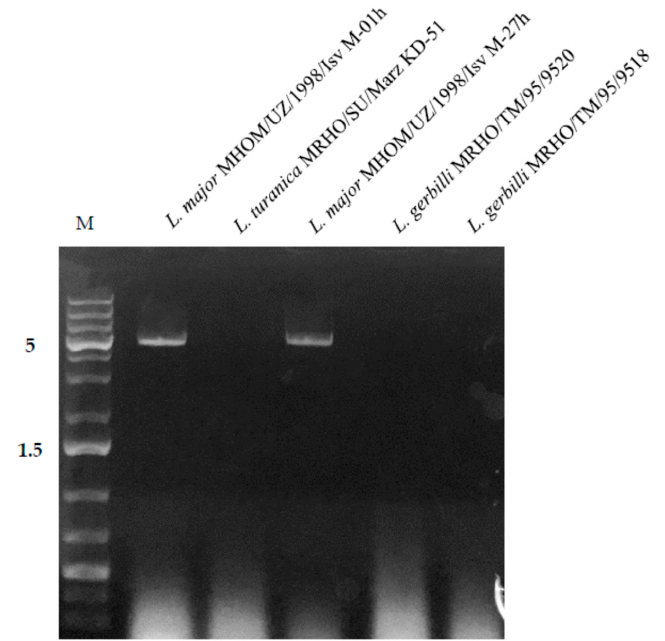
Figure 1. Detection of viral double-stranded RNA (dsRNA) on agarose gel. M; Gene Ruler 1 kb Plus ladder. Sizes on the left are in kb.